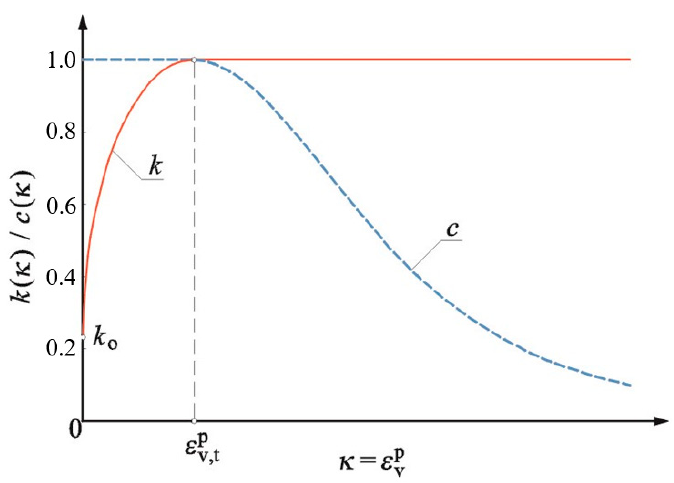
/ softening function